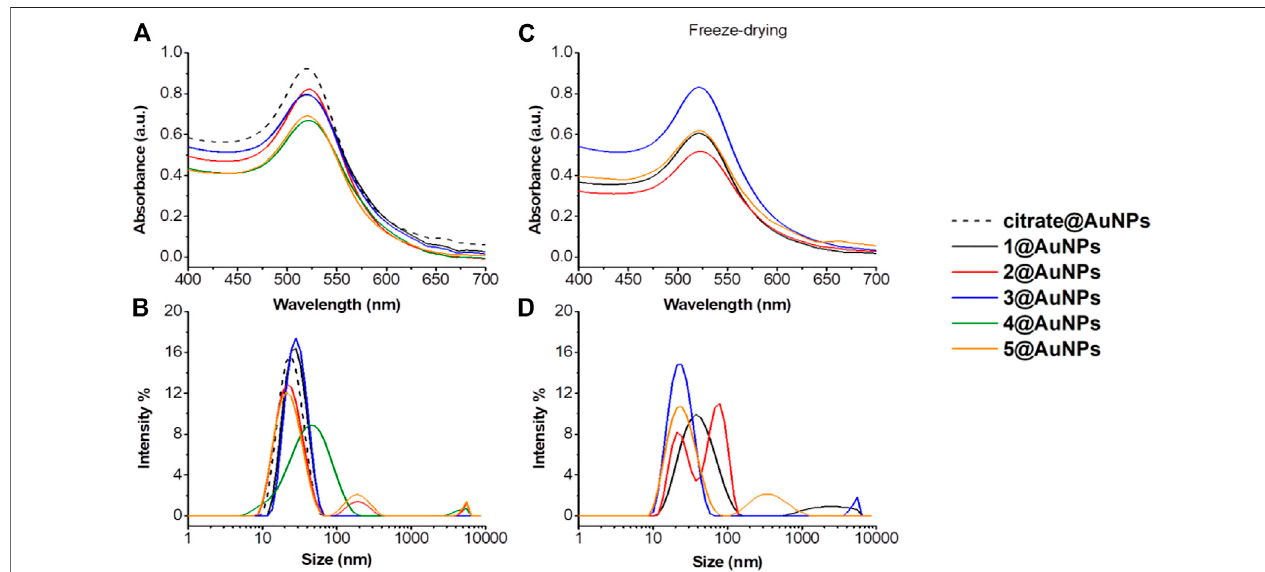
FIGURE2|(A) Absorptionspectraand (B )sizedistribution byintensityofcitrate@AuNPs(dash)andfunctionalized-AuNPswithpeptides 1 (black), 2 (red), 3 (blue), 4 (green) and 5 (orange). Mean DLS results are given for three different measurements. The hydrodynamic diameter is found 22.7 ± 0.2 nm PdI 0.2 ± 0.02 for citrate@ AuNPs, 31.8 ± 1.1 nm PdI 0.2 ± 0.03 for 1 @AuNPs, 29.1 ± 1.0 nm PdI 0.4 ± 0.02 for 2 @AuNPs, 26.3 ± 1.9 nm PdI 0.2 ± 0.01 for 3 @AuNPs, 69.2 ± 8 nm PdI 0.4 ± 0.1 for 4 @AuNPs,and27.1 ± 1.8 nmPdI0.3 ± 0.008for 5 @AuNPs. (C) Absorptionspectraand (D) sizedistributionbyintensityoffunctionalized-AuNPswithpeptides 1 (black), 2 (red), 3 (blue) and 5 (orange) after freeze-drying and subsequent water dispersion. Mean DLS results are given for three different measurements. The hydrodynamicdiameterisfound42.4 ± 3.8 nm PdI0.3 ± 0.07for 1 @AuNPs,19.6 ± 0.3and90.4 ± 3.2 nm PdI0.2 ± 0.03for 2 @AuNPs,24.7 ± 0.6 nm PdI0.3 ± 0.02for 3 @AuNPs, and 26.3 ± 0.8 nm PdI 0.4 ± 0.03 for 5 @AuNPs.